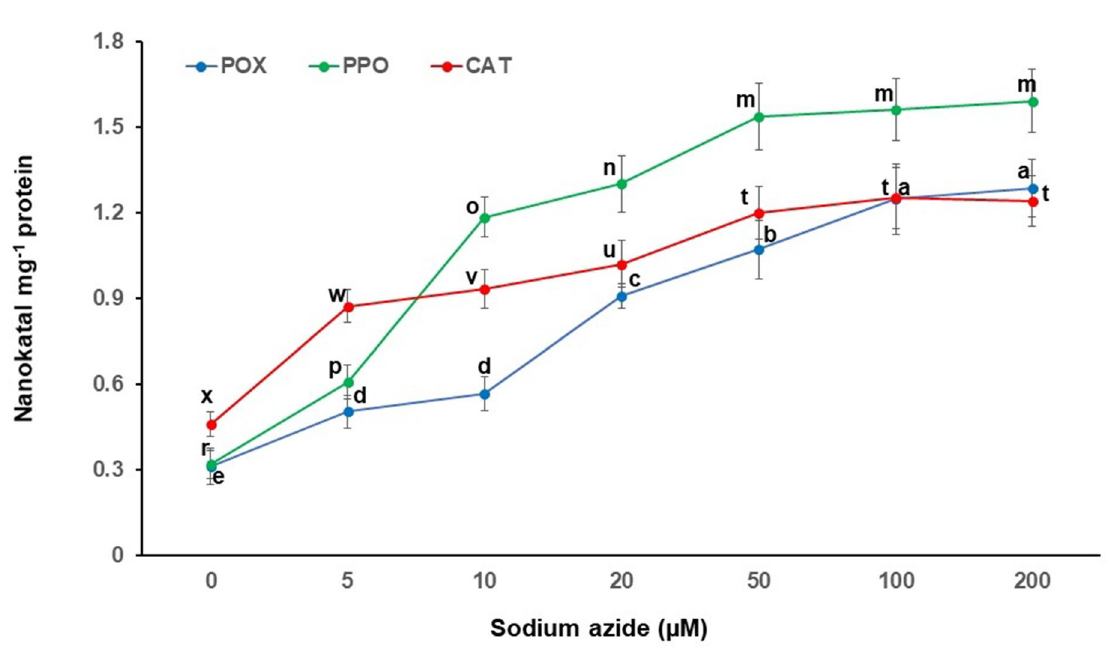
Figure 3. Graded doses of sodium azide significantly ( p < 0.001) affect activities of POX, PPO and CAT in callus extract of Nigella sativa . Vertical bars refer to ± standard deviation and histograms bearing the different alphabets in a series of data are significantly different from each other (Tukey’s HSD